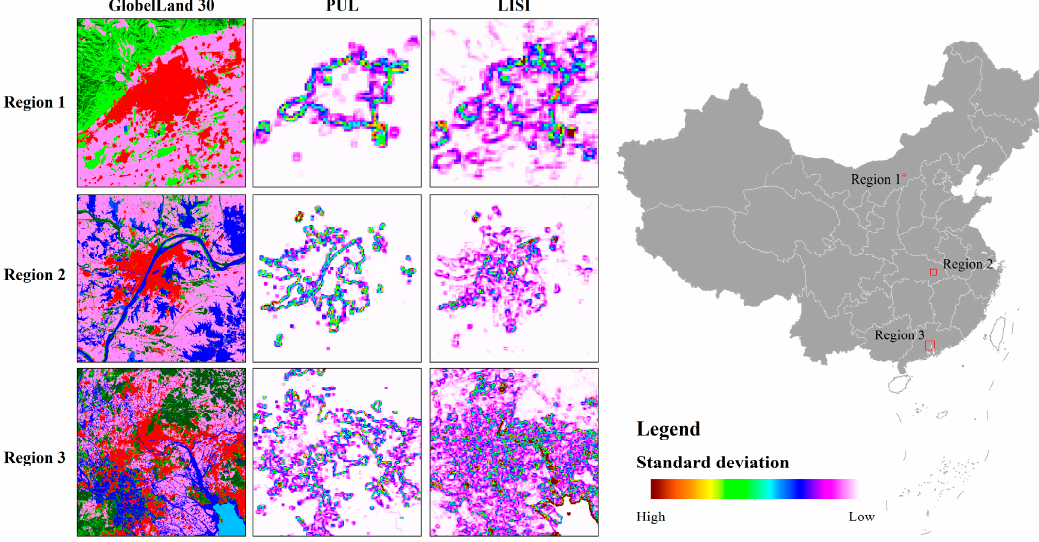
Figure 14. The standard deviations of Present-Unlabeled Learning (PUL) and Large-scale Impervious Surface Index (LISI) in three regions.